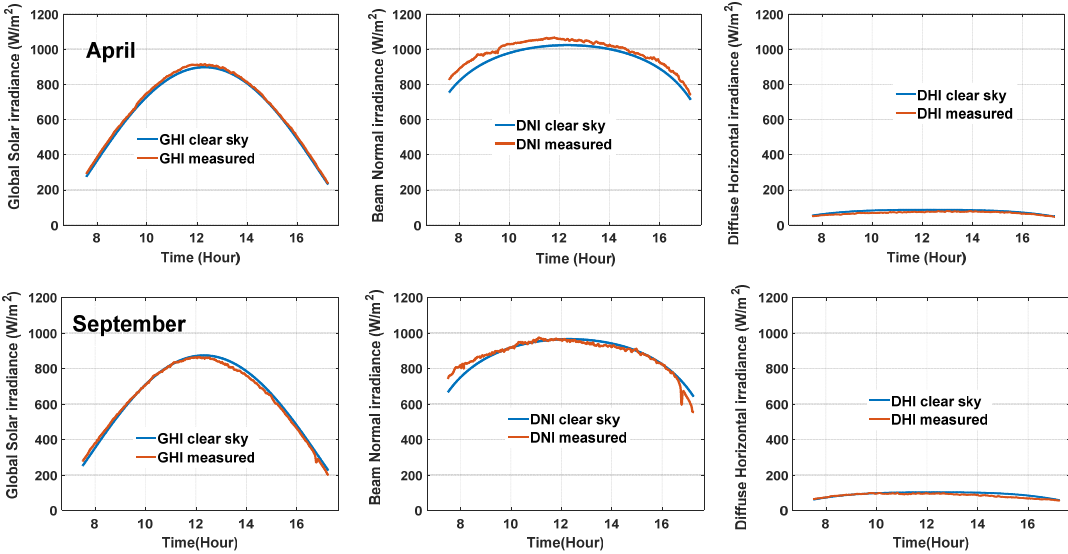
Figure 3. The ground measured and forecast results of GHI, DNI, and DHI under clear sky conditions for one day: 2 April ( top ) and 8 September ( bottom ), 2019.